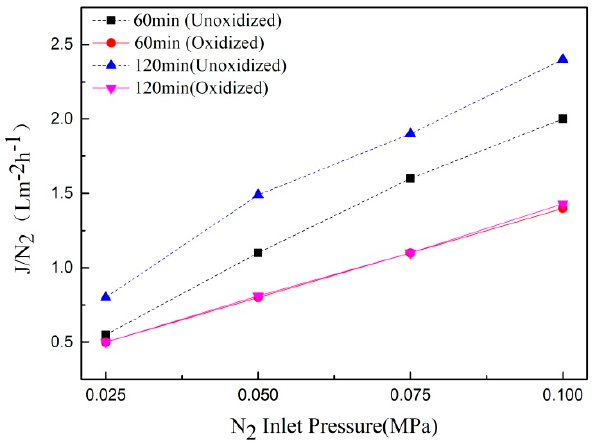
Figure 12. The gas flux curve of Ti support after oxidation at different times (800 °C, N 2 :O 2 = 2:1).